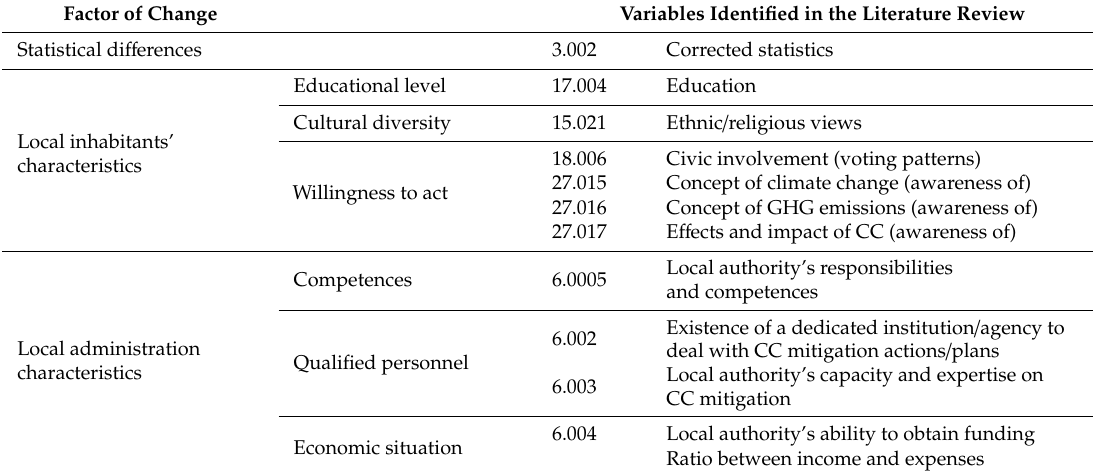
Table 3. Final list of variables and respective grouping into factors of